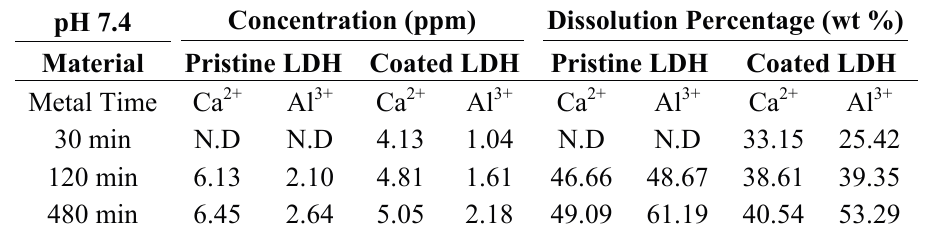
Table 3. Time dependent Ca 2+ dissolution of CaAl-LDH and E-coated CaAl-LDH at pH